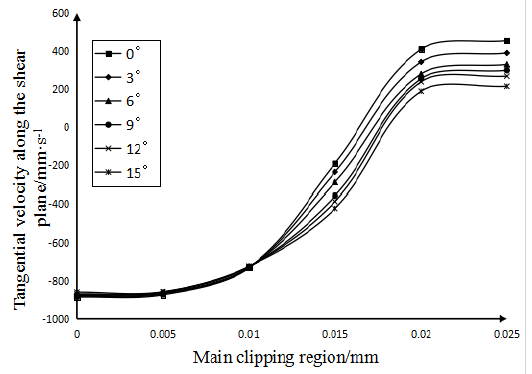
Figure 5. The influence of the tool rake angle on the tangential velocity along the shear plane.